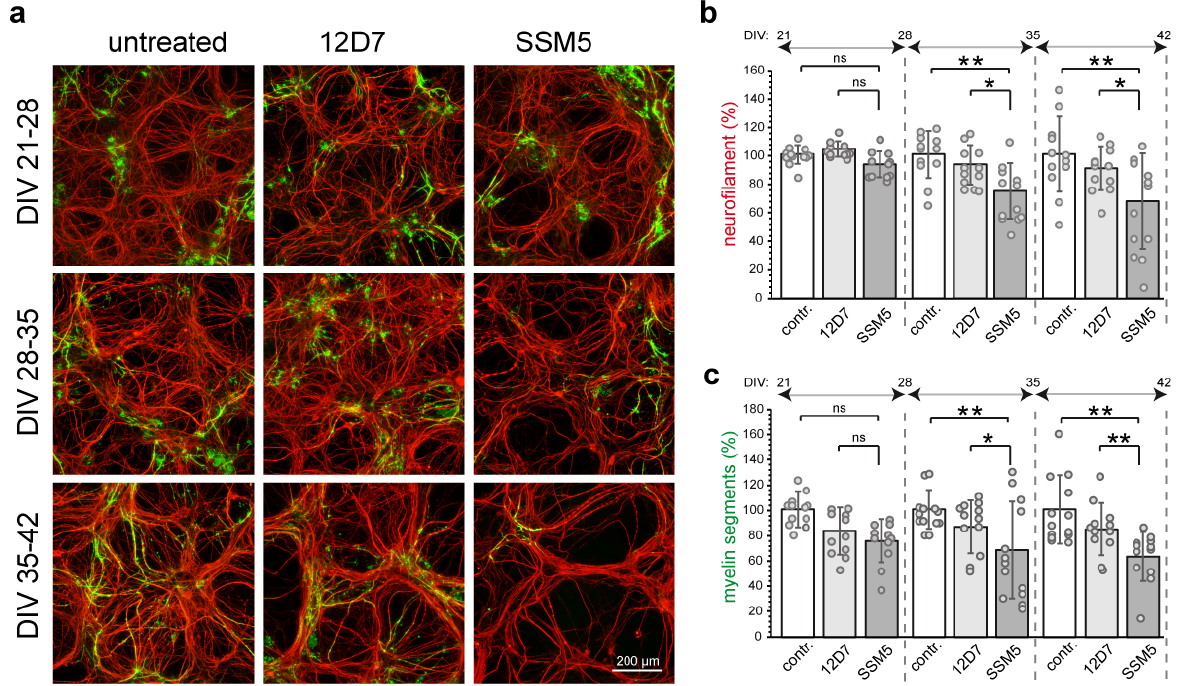
Figure 3. SSM5 antibodies have drastic effects on myelin and neuronal density. ( a ) Immunofluorescence analysis of neurites (NF200; red) and myelin (MBP; green) after treatment with SSM5 (10 μ g/mL) or 12D7 (10 μ g/mL) for one week at different stages of myelination. Scale bar: 200 μ m. Quantification of neurofilament density ( b ) and myelin segments ( c ) following treatment with SSM5 starting at DIV 21, DIV 28, DIV 35. One ‐ way ANOVA with Tukey multiple comparison, showed significant differences between SSM5 vs. 12D7 vs. control groups; n = 4; technical replicates = 3; * p < 0.05, ** p < 0.01; ns, non ‐ significant. Note: detrimental effect of SSM5 was more pronounced at later stages of culture and reached statistical significance after DIV 28. Mean ± SEM.